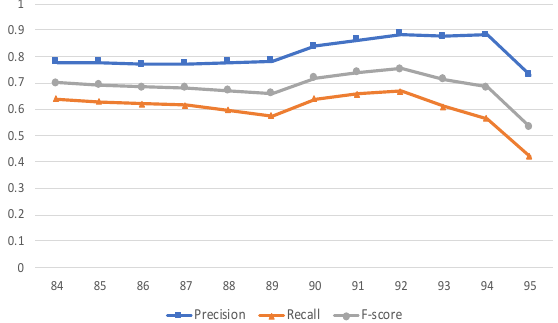
Figure 12. Average recommendation accuracy from the varying threshold value with five projects.